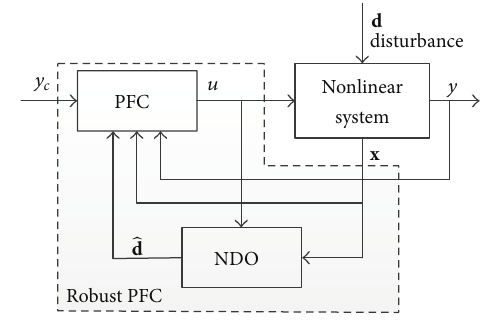
Figure 1: The framework of the robust